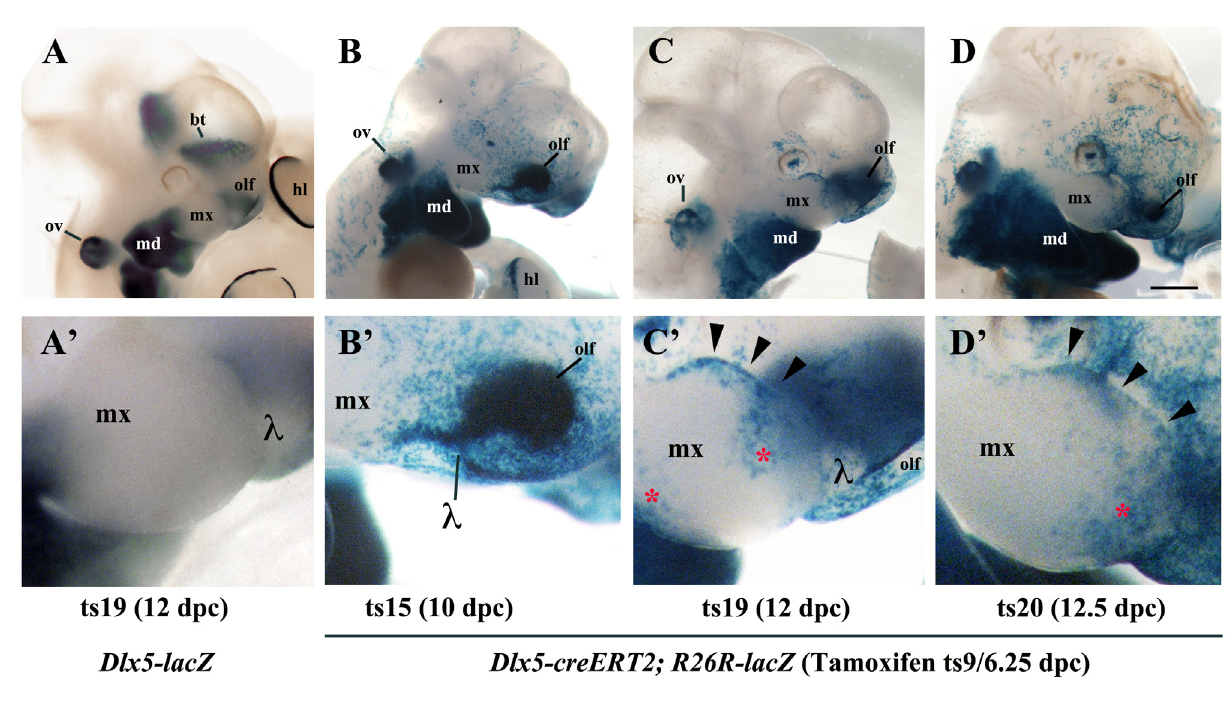
Figure 2. Lineage of Dlx5 -expressing cells in the maxillary arch. β -Galactosidase activity in the cephalic region of Dlx5-lacZ ( A, A’ ) and Dlx5-creERT2 ; R26R-lacZ mouse embryos ( B–D’ ). In all cases pregnant dams were treated with tamoxifen at 7dpc/Theiler stage 9 (ts9) and embryos were collected at the indicated Theiler stage. A, A’ ) As expected, even after tamoxifen treatment, Dlx5 is expressed in the mandibular arch (md), in the olfactory pit (olf), in the otic vesicle (ov), in the striatum (st) and in the hind limb (hl), but not in the maxillary arch. B, B’ ) Permanent activation of lacZ reporter expression in derivatives of Dlx5 -expressing early progenitors (ts9) reveals the presence of a positive cellular contingent in the ts15 lambdoidal junction ( λ ) between the olfactory pit and the maxillary process. C, C’ ; D, D’ ) At later developmental stages (ts19, ts20) a contingent of lacZ positive cells populates the distal domain of the maxillary arch. hl, hind limb; md, mandibular arch; mx, maxillary arch; olf, olfactory pit; ov, otic vesicle; bt, basal telencephalon; λ , lambdoidal junction; red asterisk/black arrowheads, territories of the maxillary arch colonized by derivatives of Dlx5 -expressing progenitors. Bar: A–D 1mm; A’–D’